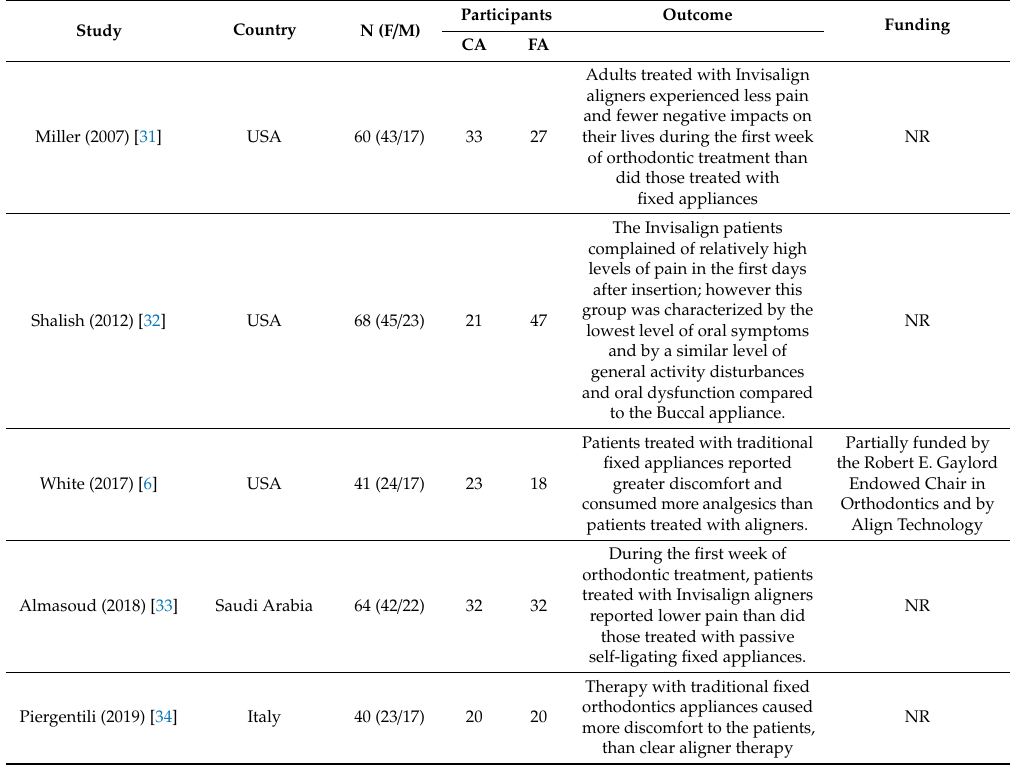
Table 1. Included studies characteristics.